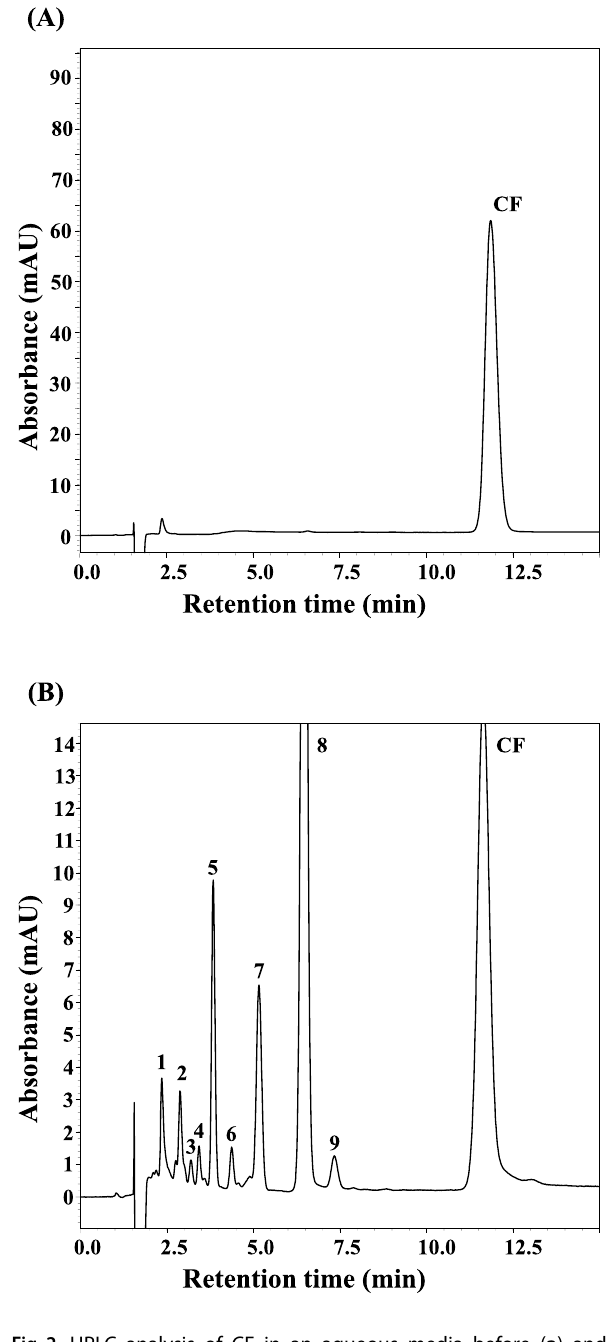
Fig. 2 HPLC analysis of CF in an aqueous media before ( a ) and after UV irradiation for 3 days ( b ). Detection wavelength: 254 nm. Retention times of detected peaks were as follows; peak 1: 2.4 min, peak 2: 2.9 min, peak 3: 3.2 min, peak 4: 3.4 min, peak 5: 3.8 min, peak 6: 4.4 min, peak 7: 5.2 min, peak 8: 6.5 min, peak 9: 7.3 min, CF: 11.6